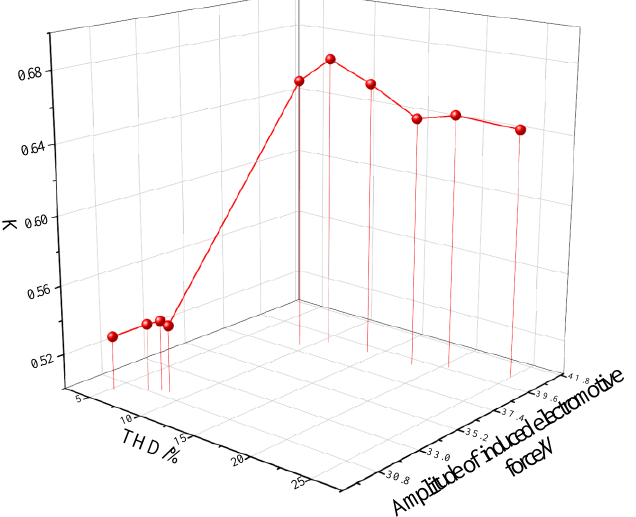
Figure 13. The relationship between the two optimization objectives and the matching coefficient.